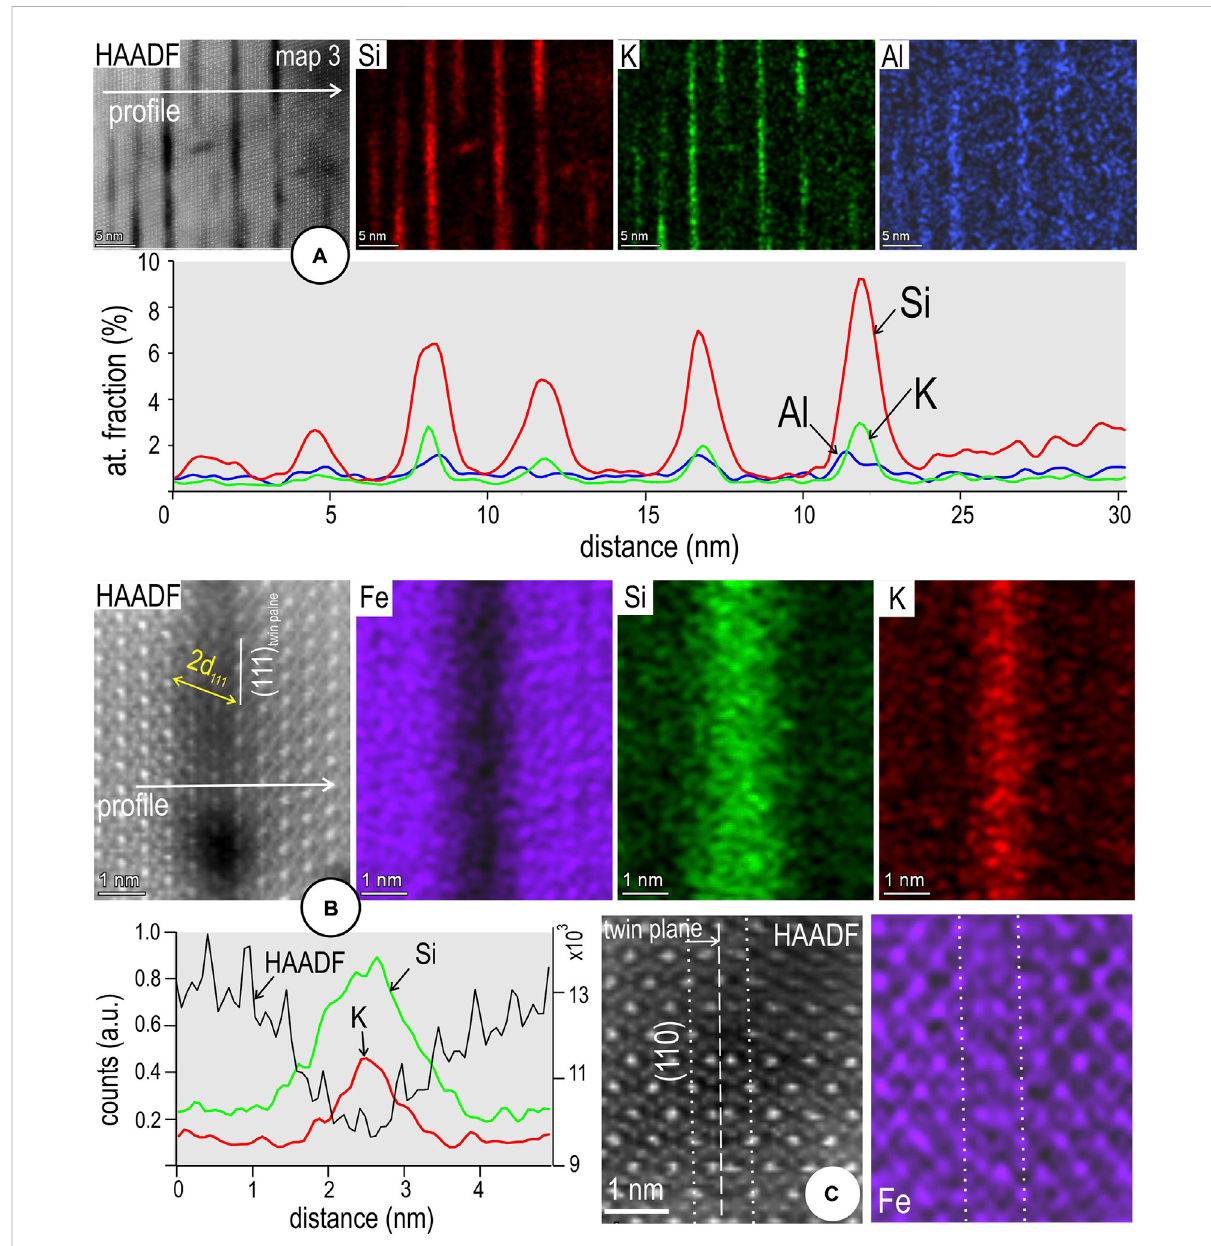
FIGURE 6 (A) Image,STEMEDSelementmapsandlinepro fi leacrossdomaininsilicianmagnetitedisplaying(111) Si-Fe rods(2d 111 widthofmagnetite)which are incipiently replaced by muscovite (foil Mt#1). The “ sericitisation ” is depicted by K and Al maps and element pro fi les showing an overlap with Si distribution. (B) Atom-resolution image, STEM EDS maps (Fe, Si, K) and EDS line pro fi le across a single 2d 111 rod showing K distribution through the centreoftheSi-bearing, Fe-depleted band. (C) Atomic-resolutionimageandSTEMEDSmapforFeacrossa(110)twinplane inmagnetite.Note the match between the image and map with respect to Fe atoms. This type of defect shows no distinct pattern with respect to Si